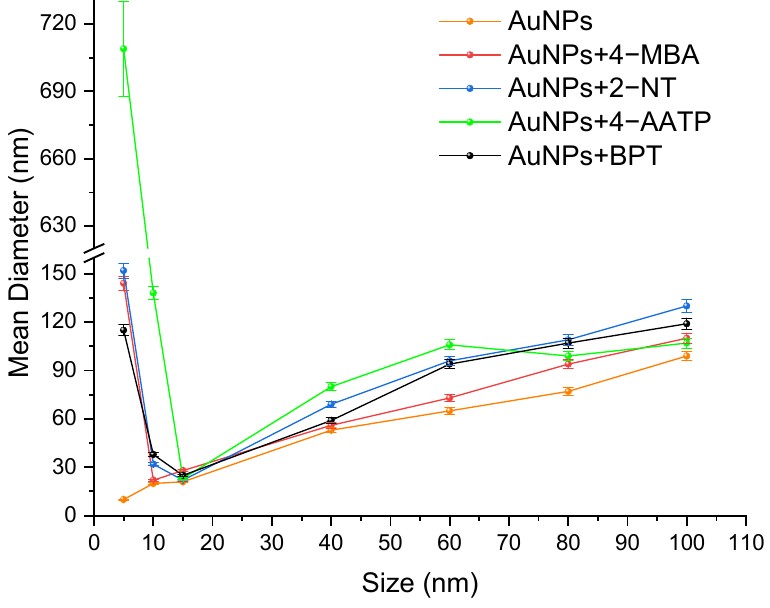
Figure 4. The DLS-derived AuNP size vs. nominal size plot for all the solutions. Error bars: standard deviation.